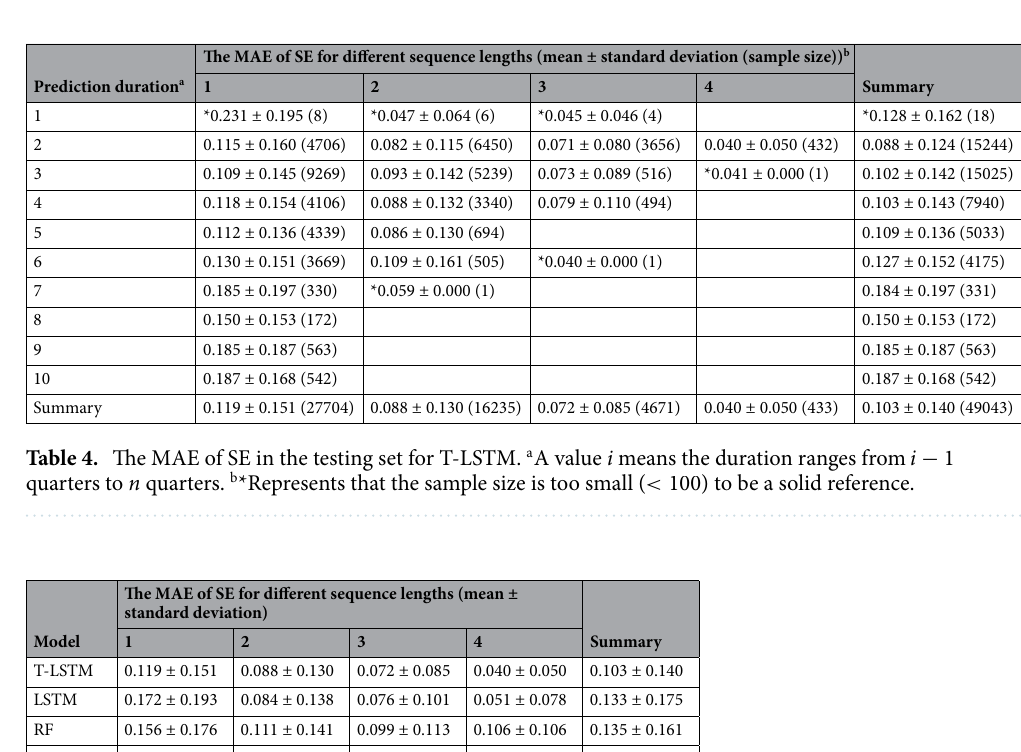
The MAE of SE for different sequence lengths (mean ± standard deviation (sample size)) b Prediction duration a